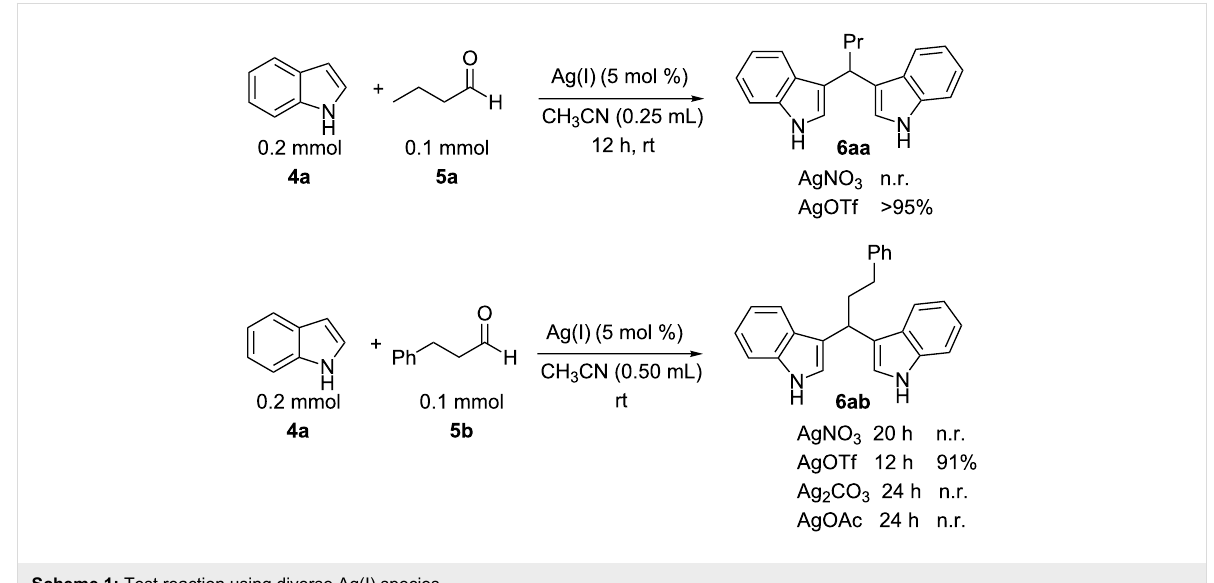
Scheme 1: Test reaction using diverse Ag(I)